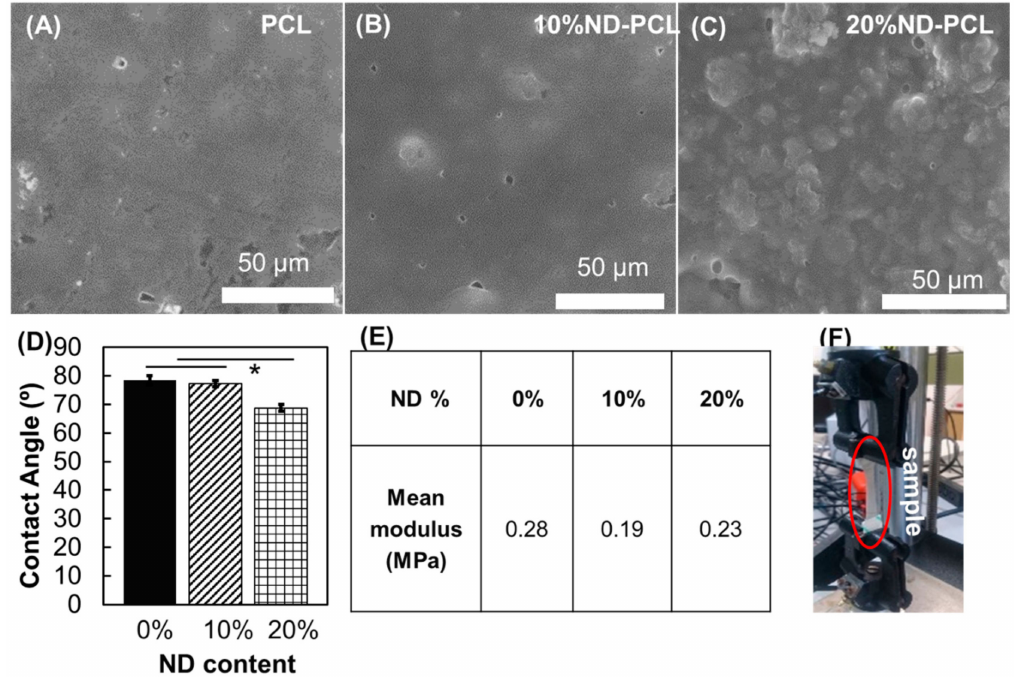
Figure1. ( A – C )SEMsurfaceimagingof( A )polycaprolactone(PCL)( B )nanodiamond-polycaprolactone (ND-PCL) films with 10% ND loading and ( C ) 20% ND loading. ( D ) Contact angle measurement (n = 3, student t -test ( p ≤ 0.05)). ( E ) Mean tensile modulus for films with di ff erent ND loadings (n ≥ 6) and ( F ) setup of the tensile